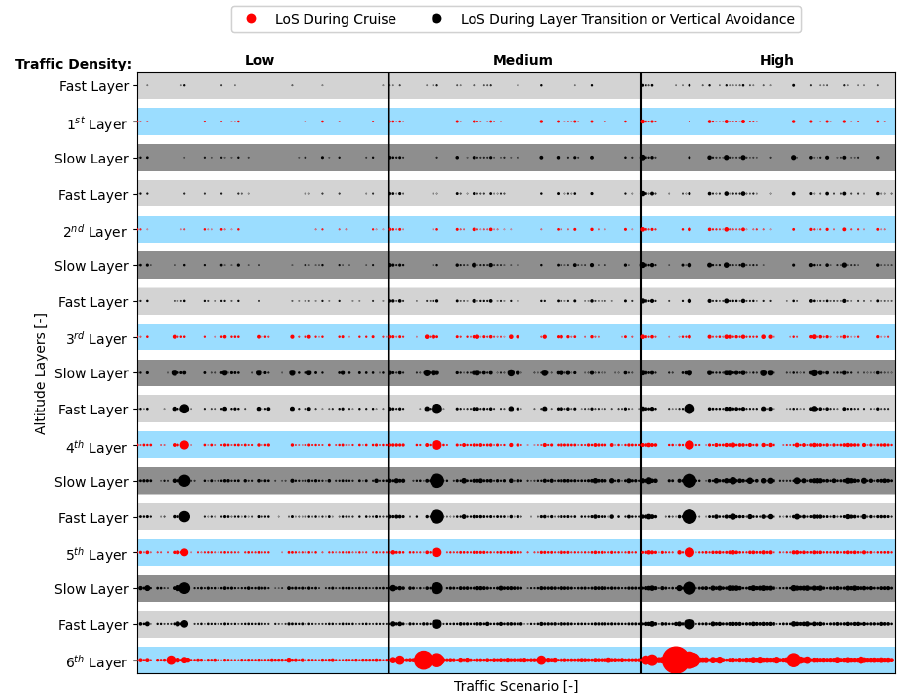
Figure 20. Altitudes at which LoSs occurred with the structure produced by the RL agent. The sizes of the points vary between a maximum value of 7519 and a minimum value of 1 LoS. All traffic densities had 75 traffic scenarios, with the initial direction(s) and the number of turns following the same order as shown during the training